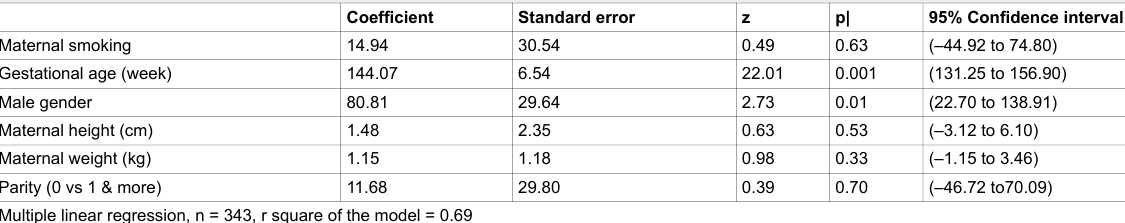
Table 3a: The impact of maternal smoking on the birth weight of very preterm neonates.